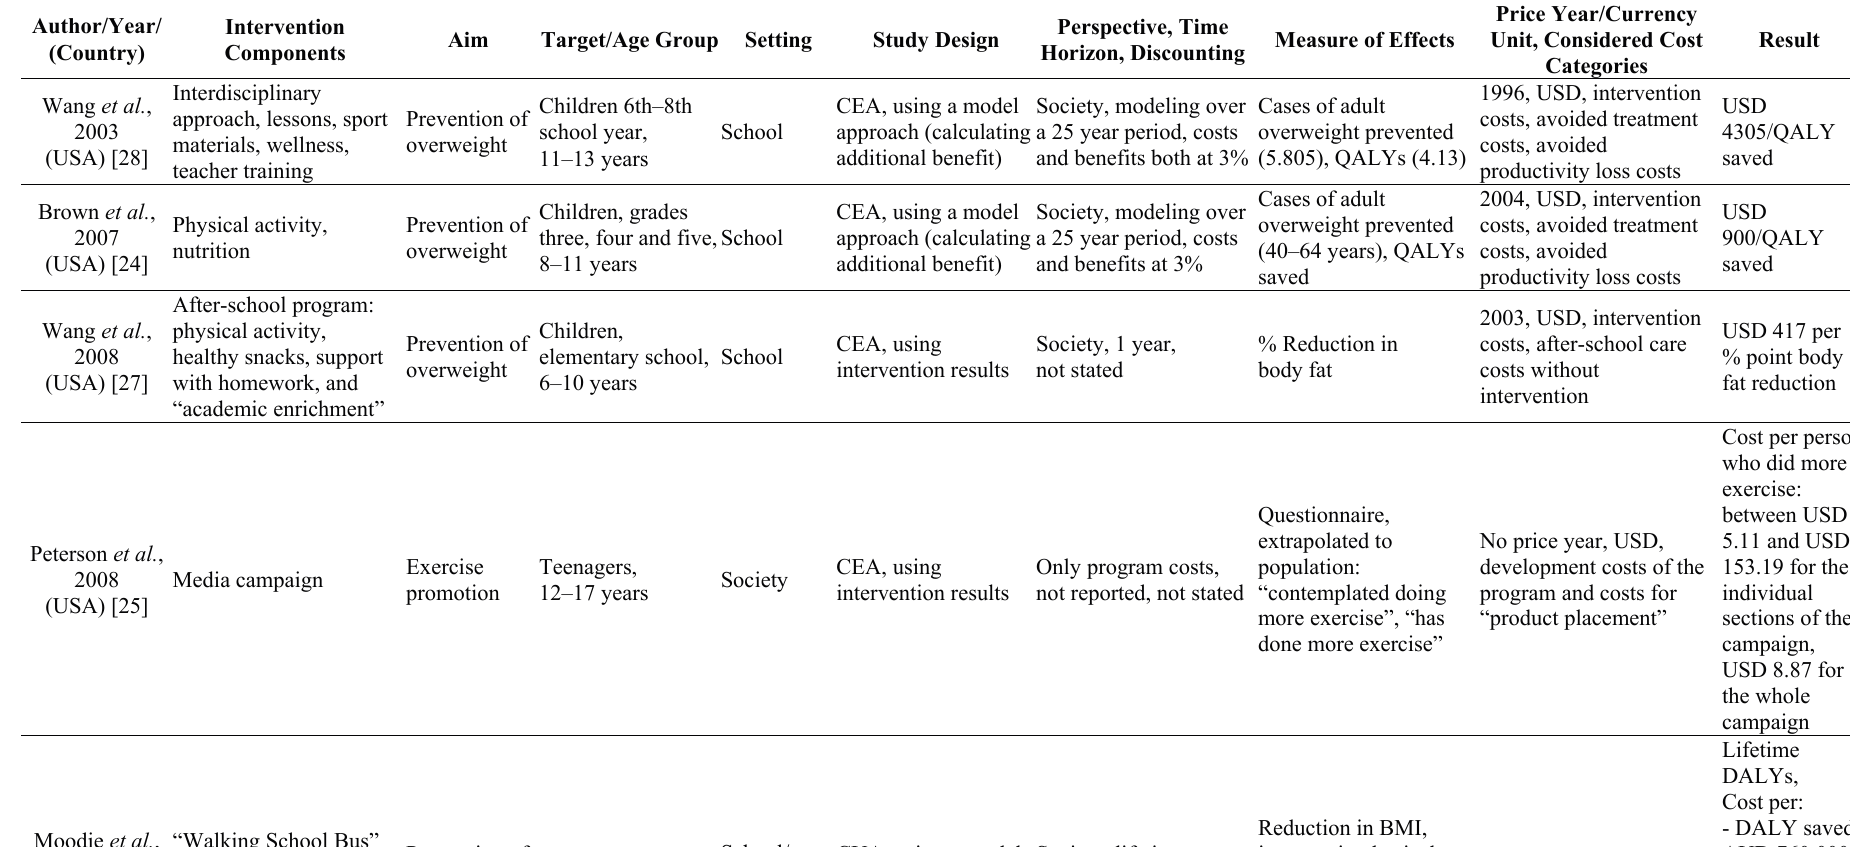
Table 2. Study description and overview of economic evaluations of physical activity programs (sorted by publication